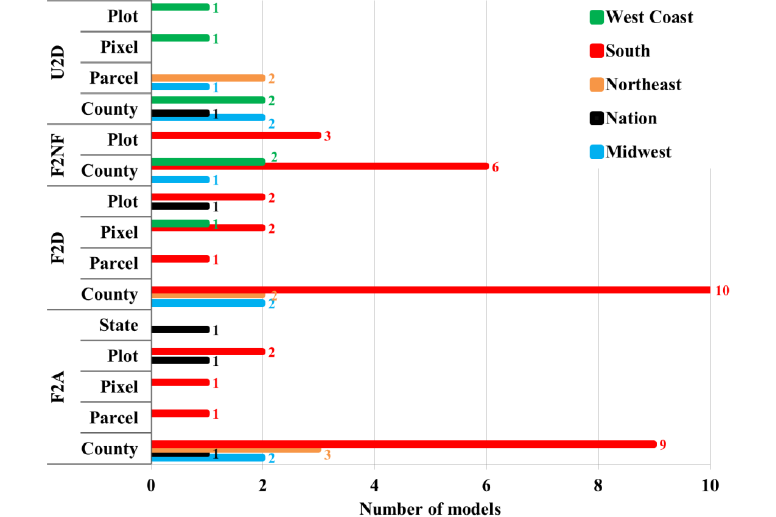
Figure 2. Spatial resolutions by geographic region and model types included in a meta-analysis of 64 econometric models predicting forestland